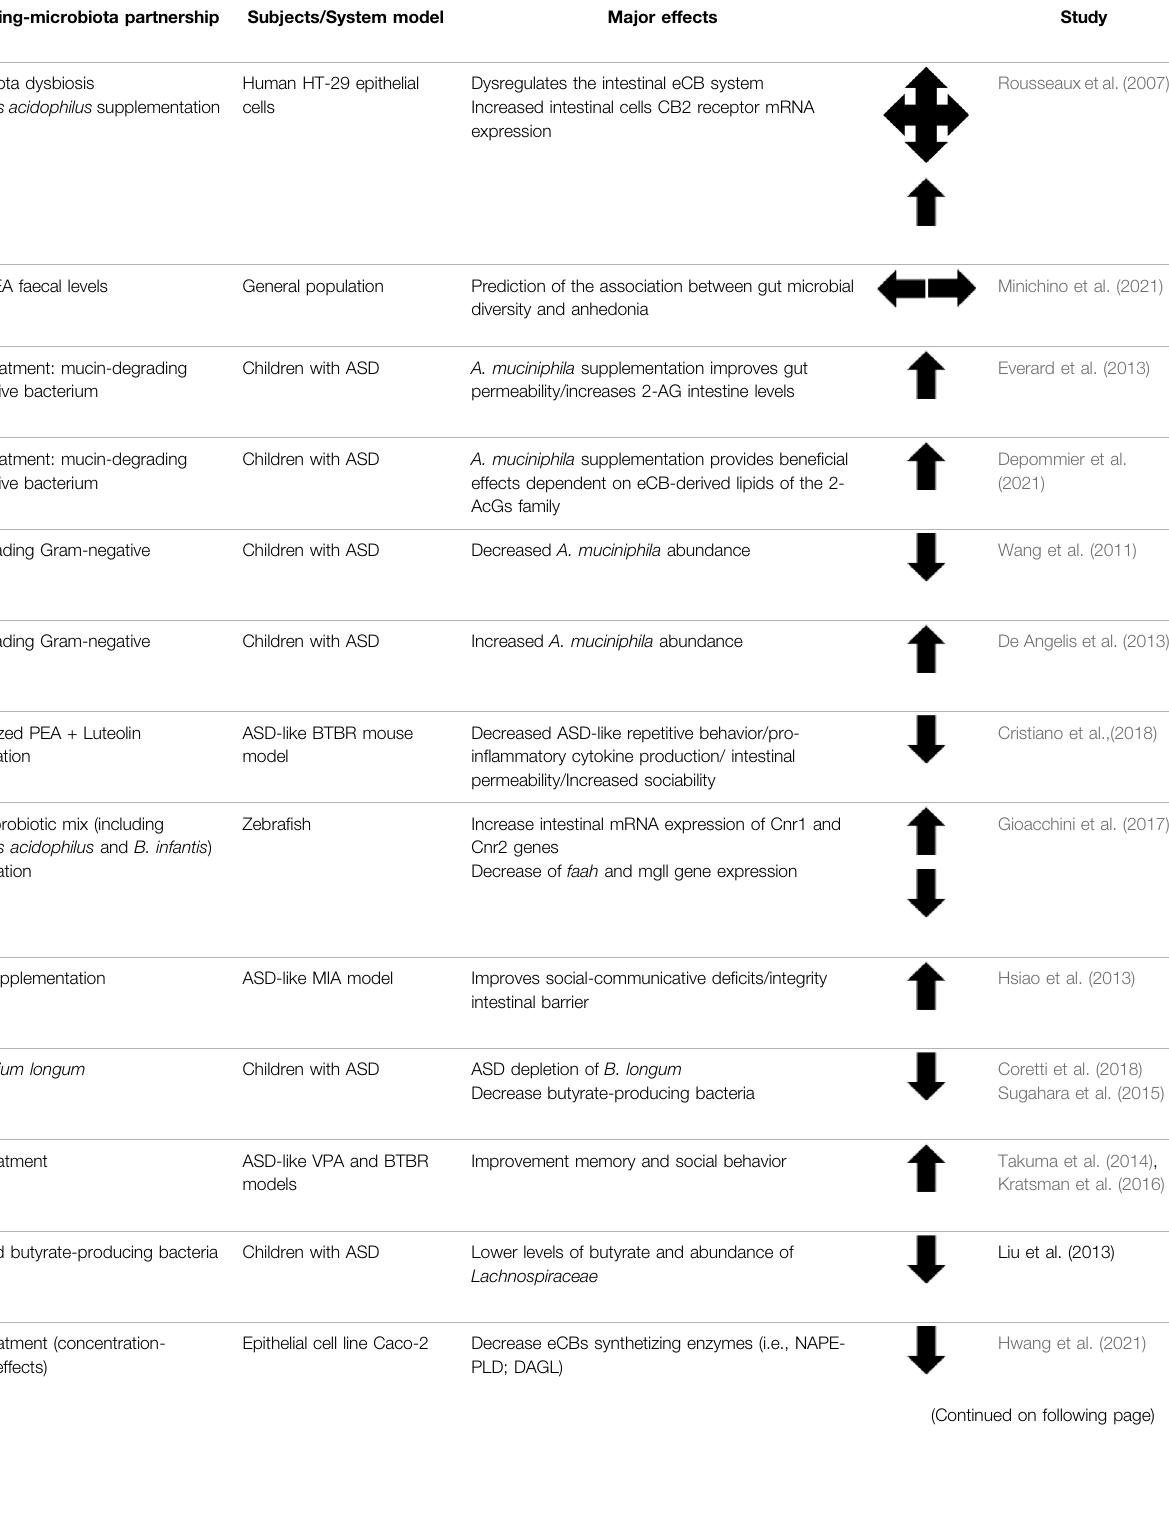
TABLE 2 | Summary table of the key studies involving eCB signaling and gut microbiota crosstalk in both patients with ASD and ASD-like animal